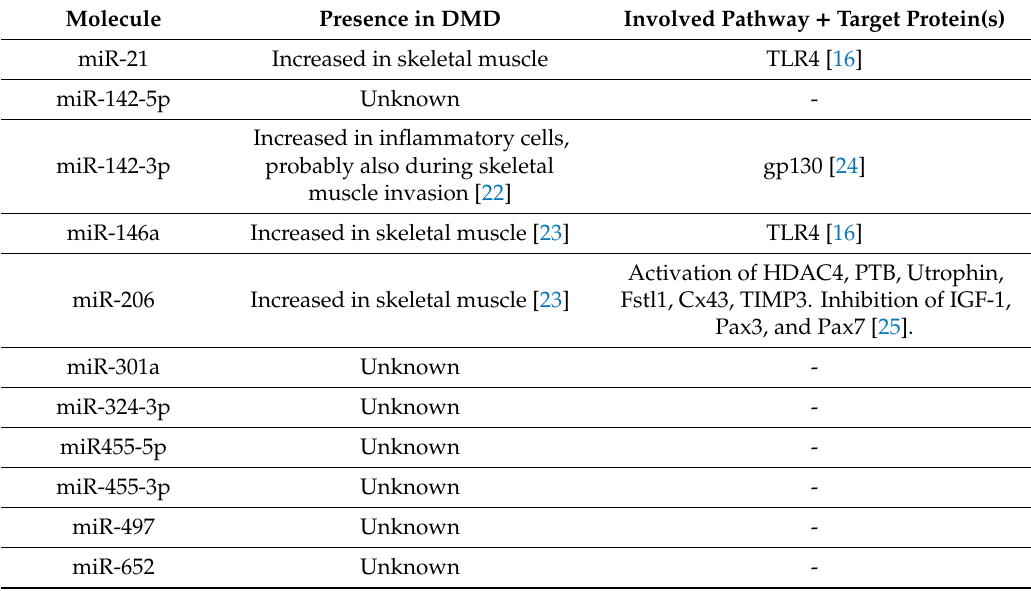
Table 1. Overview of miRNAs in Duchenne muscular dystrophy (DMD), their influence on other cellular pathways and their target